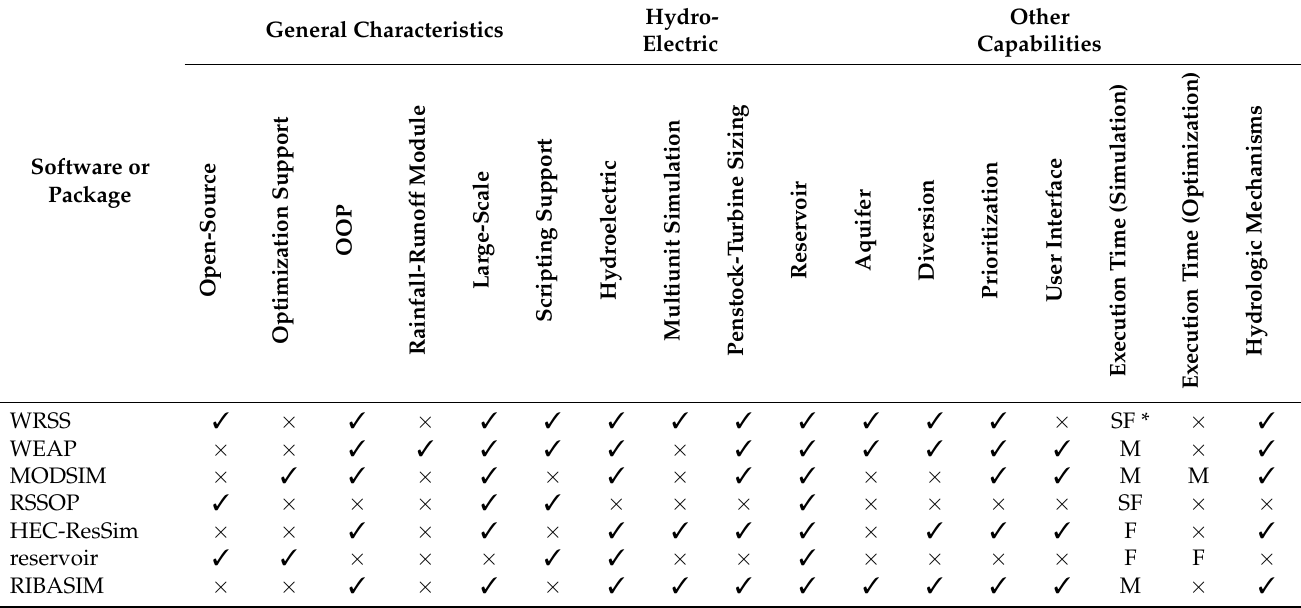
Table 1. Comparison of water resources